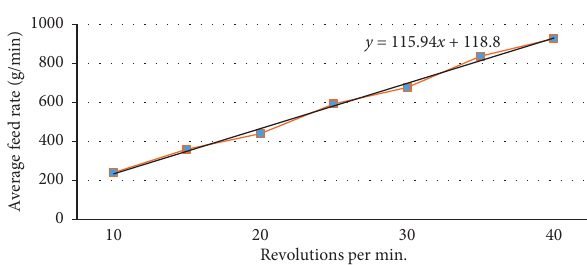
Revolutions per min. Figure 2: Plot of average feed rate against revolution per